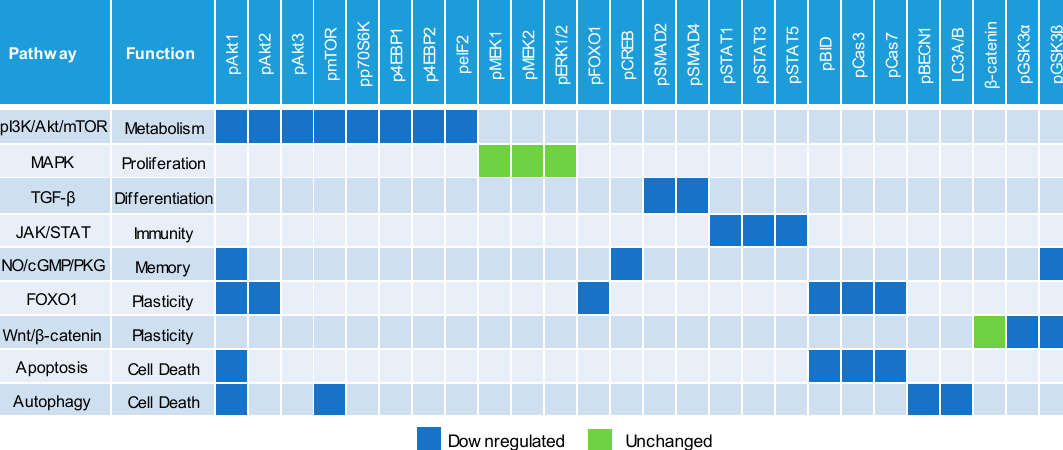
Figure 8. Downregulation of multiple cell signaling pathways by a CBD oil. Blue and green squares indicate downregulated and unchanged protein profiles, respectively, at 24 h post-treatment with CBD oil V1 at 100 µ g / mL final CBD concentration. Squares in other colors indicate proteins that are not applicable to the given pathways.